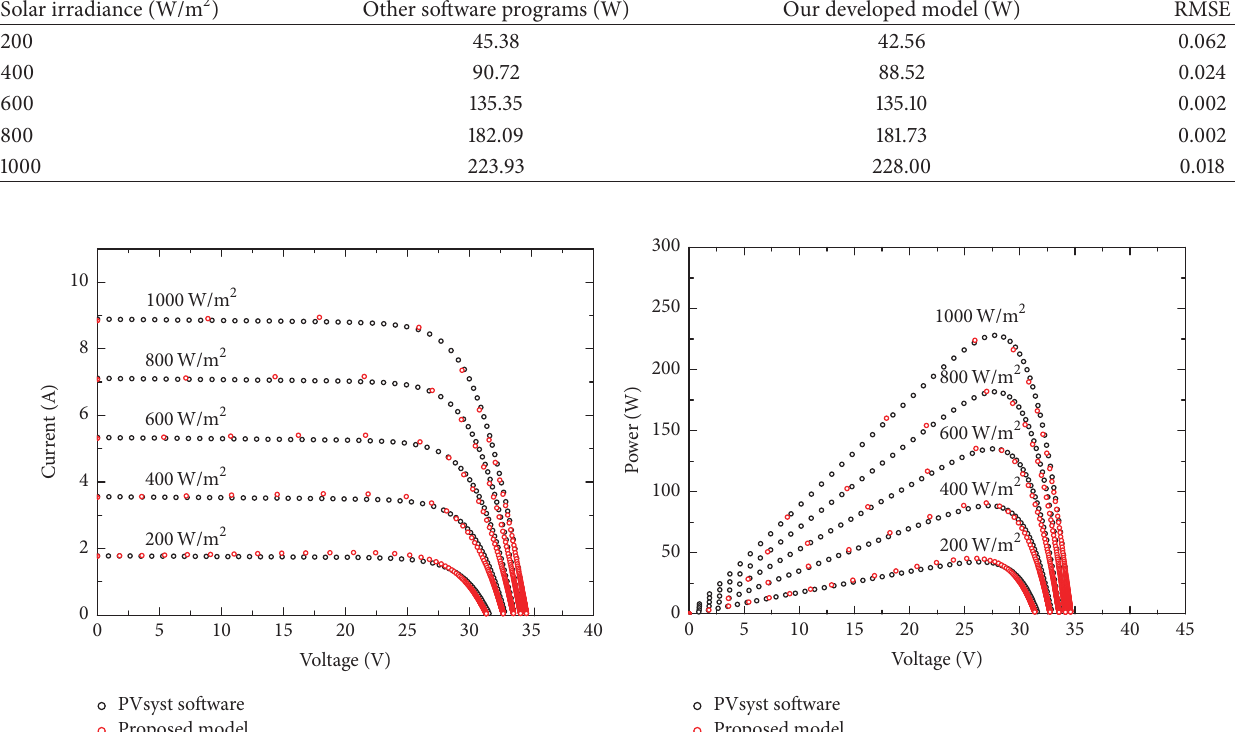
Figure 5: PV module’s 𝐼 - 𝑉 curves and 𝑃 - 𝑉 curves under difference solar irradiance (module temperature = 45 ∘ C).